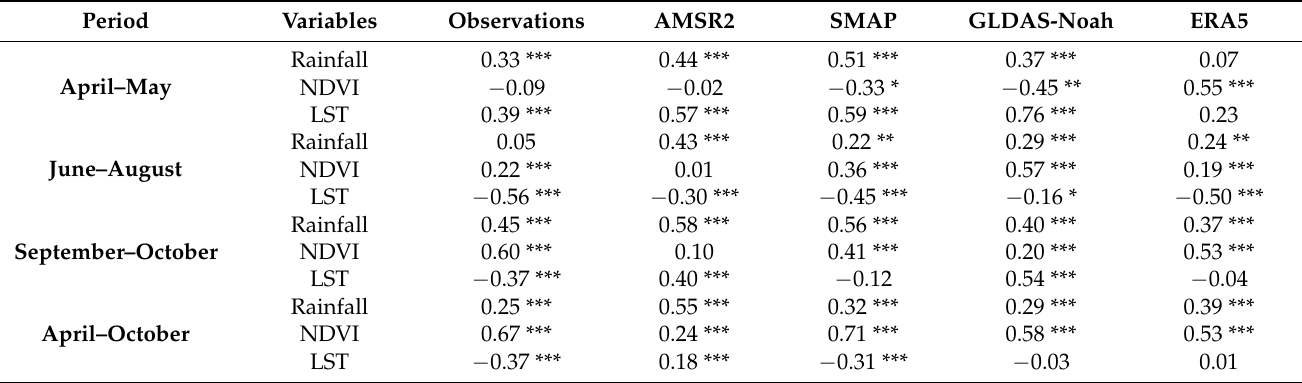
Table 5. The β from multiple stepwise regression analysis between SM (in situ observed, AMSR2, SMAP, GLDAS-Noah, and ERA5) and influencing factors (rainfall, NDVI, and LST) in different seasons from 2015 to 2016 in the TP. *, **, and *** represent the statistically significant at 95%, 99%, and 99.9% confidence levels,